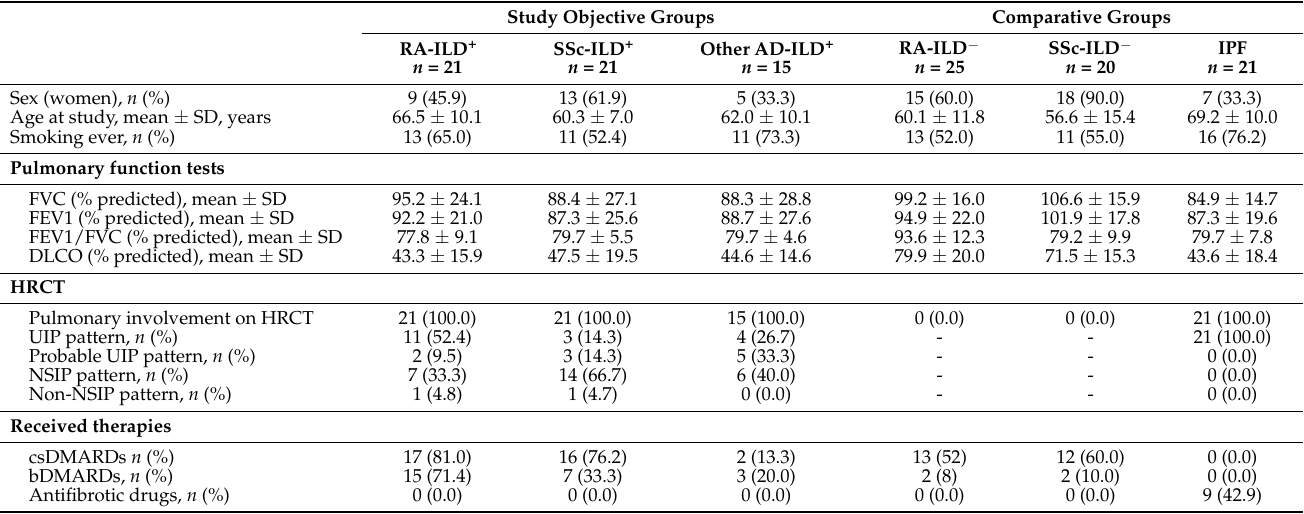
Table 1. Main characteristics of all the patients of the study objective groups and the compara- tive